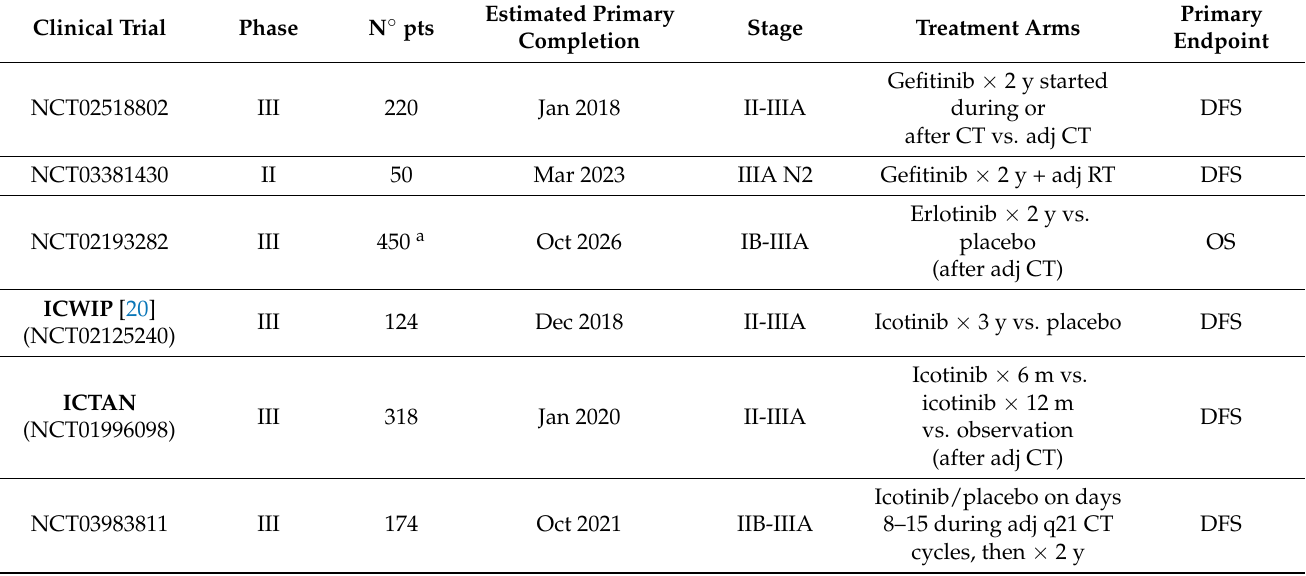
Table 2. Ongoing clinical trials with EGFR-TKIs in the adjuvant